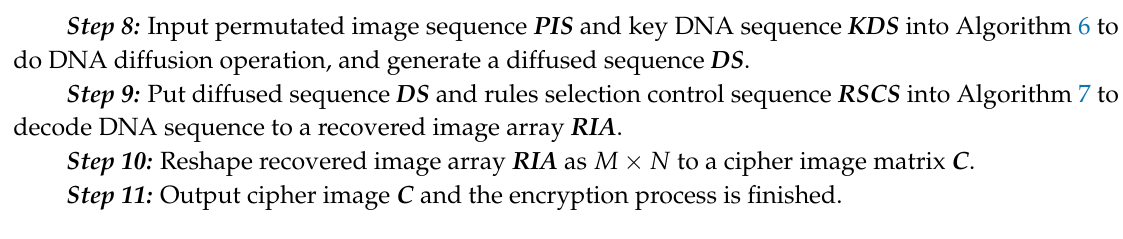
Algorithm 1 Generation algorithm of rules selection control sequence (RSCS).